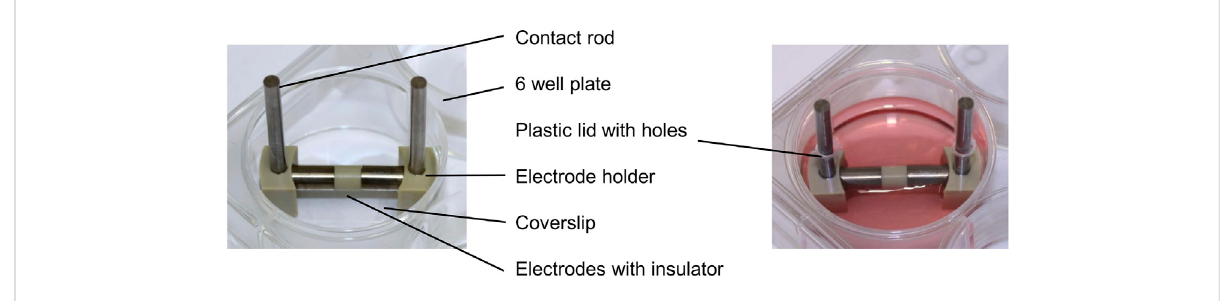
FIGURE 1 Electricalstimulationdevicewithoutandwithculturemediumina6-wellplateconsistingofcontactrods,electrodeholders,andtheelectrodes connected over an